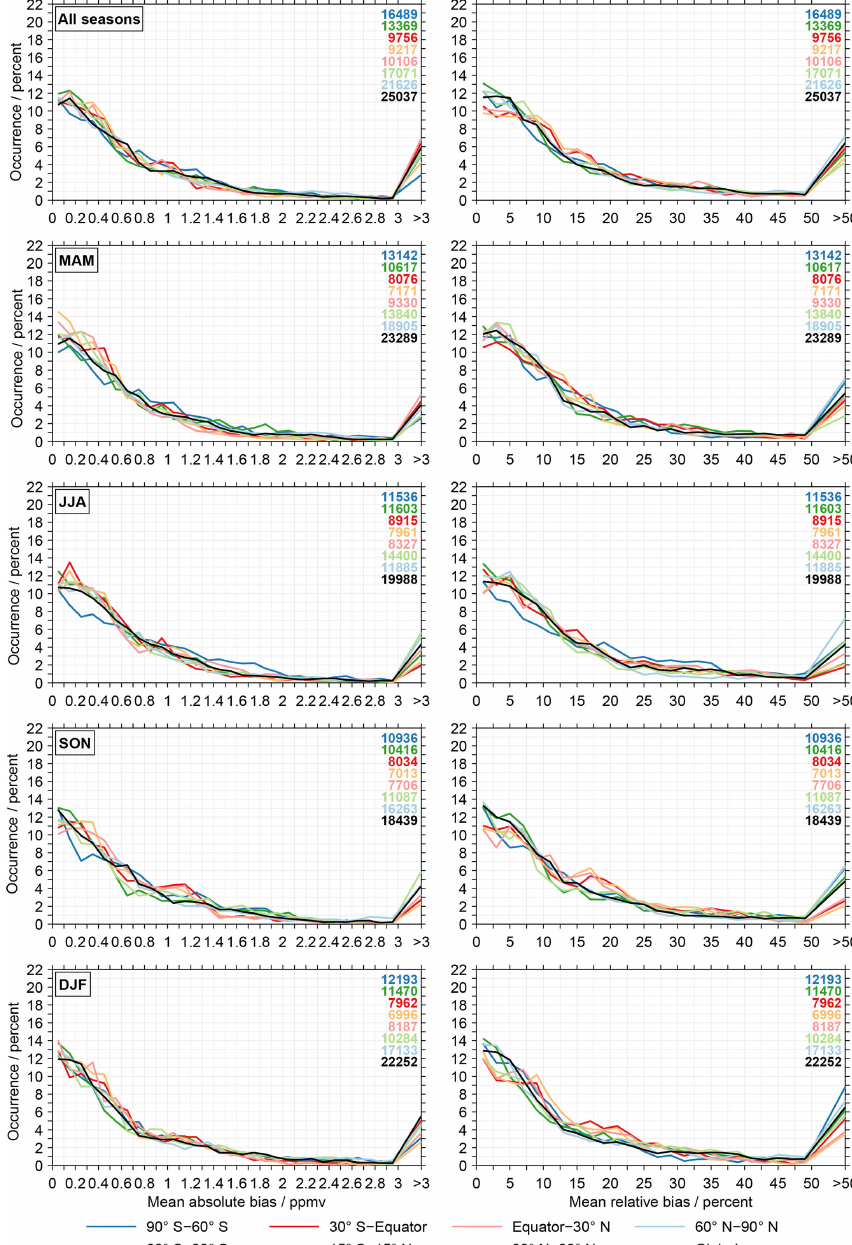
Figure 7. Histograms of the absolute (left column) and relative biases (right column) considering results from the entire altitude range. As in the previous figure the different rows consider different seasons, while the different latitude bands are colour coded in the individual panels. Also, these histograms take into consideration the aggregation of the MIPAS results. The increase at the right end of the panes comes from the integration over all biases larger than 3ppmv and 50%,